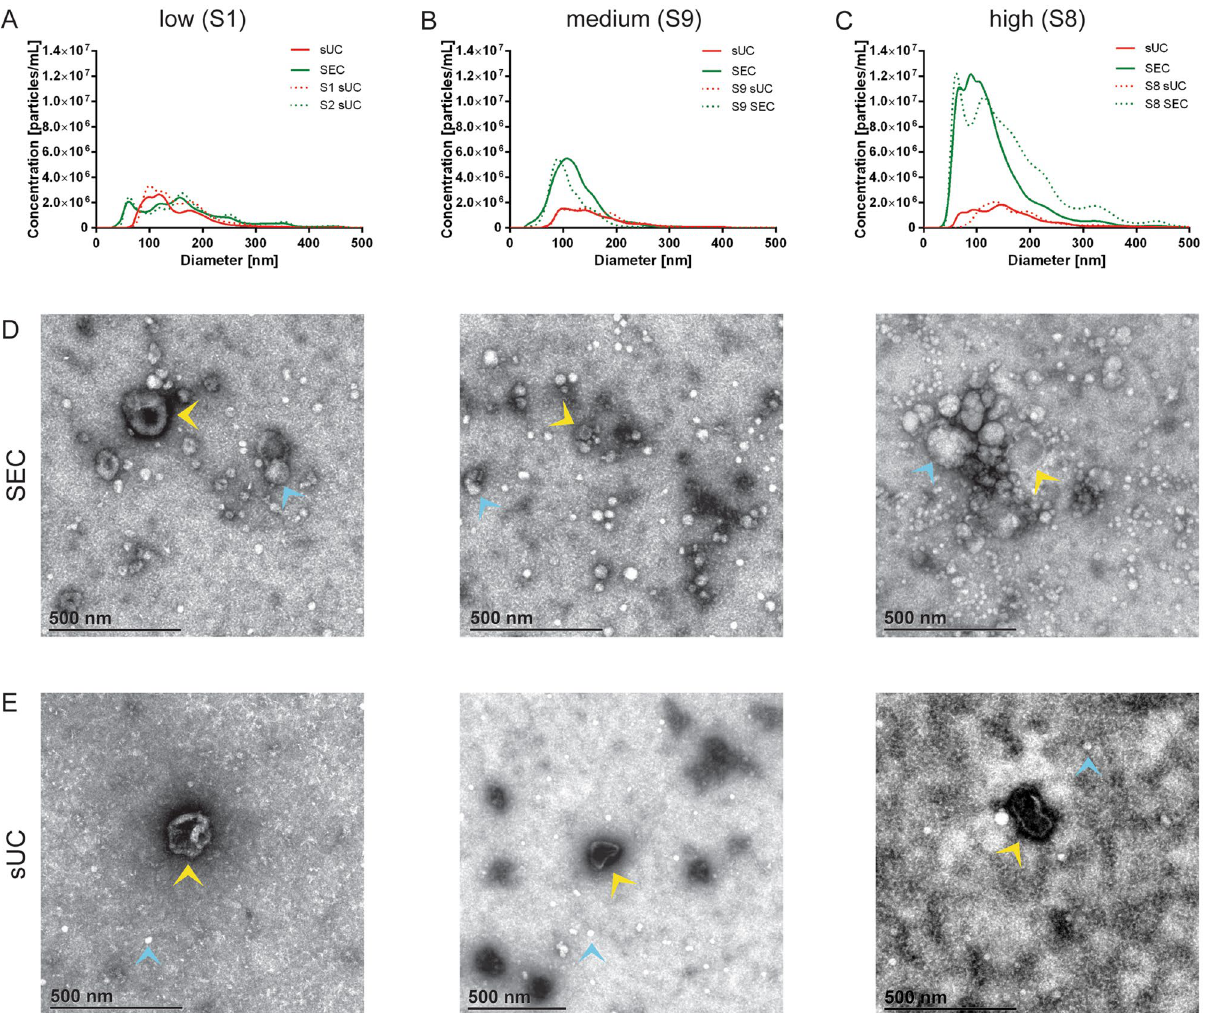
Figure 4. Comparison of representative TEM images of enriched nanoparticles from human blood plasma after SEC and sUC. ( A ) Comparison of NTA signal for average (solid line) and representative (dotted line) samples after sUC and SEC in samples with low, ( B ) medium and ( C ) high concertation of particles after SEC. ( D ) TEM images of representative samples after EVs enrichment with SEC. ( E ) TEM images of representative sample of each group after EVs enrichment with sUC. Yellow triangles indicate EVs, blue triangles indicate lipoproteins. TEM transmission electron microscopy, NTA nanoparticle tracking analysis, sUC sucrose cushion ultracentrifugation, SEC size exclusion